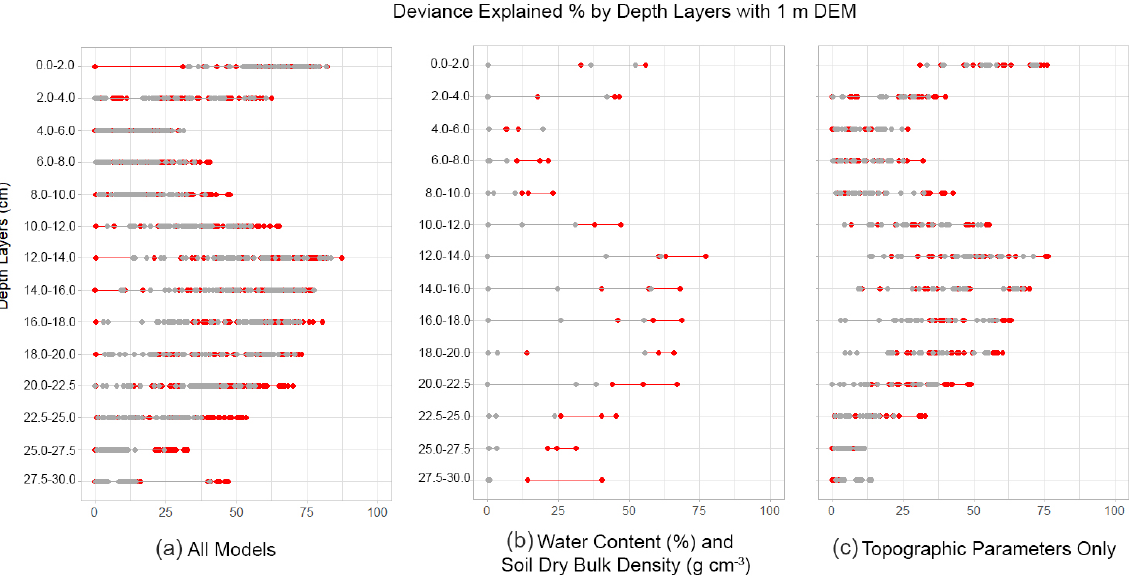
Figure 10. Deviance-explained percentages using the 1m DEM. (a) All parameter including combinations soil properties and topographic parameters. (b) Parameter combinations with only water content (%) and soil dry bulk density (gcm − 3 ). (c) Parameter combinations with only topographic parameters.